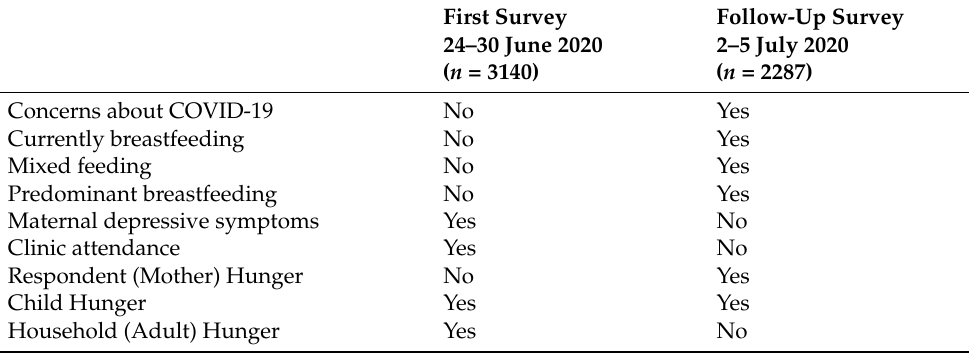
Table 1. Data collected in the first and follow-up round of the national survey.